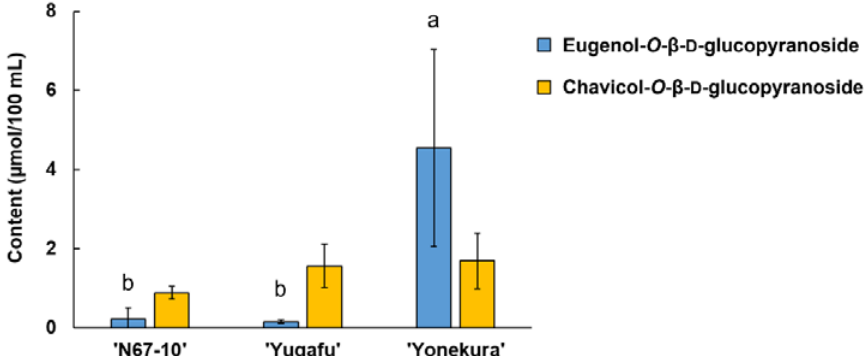
Figure 3. Glycosidically bound volatile compounds of Okinawan pineapple ( µ mol/100 mL). Each value is expressed as the mean ± standard deviation of three replicates. Means in the same group followed by the same letter are not significantly different at p < 0.05.